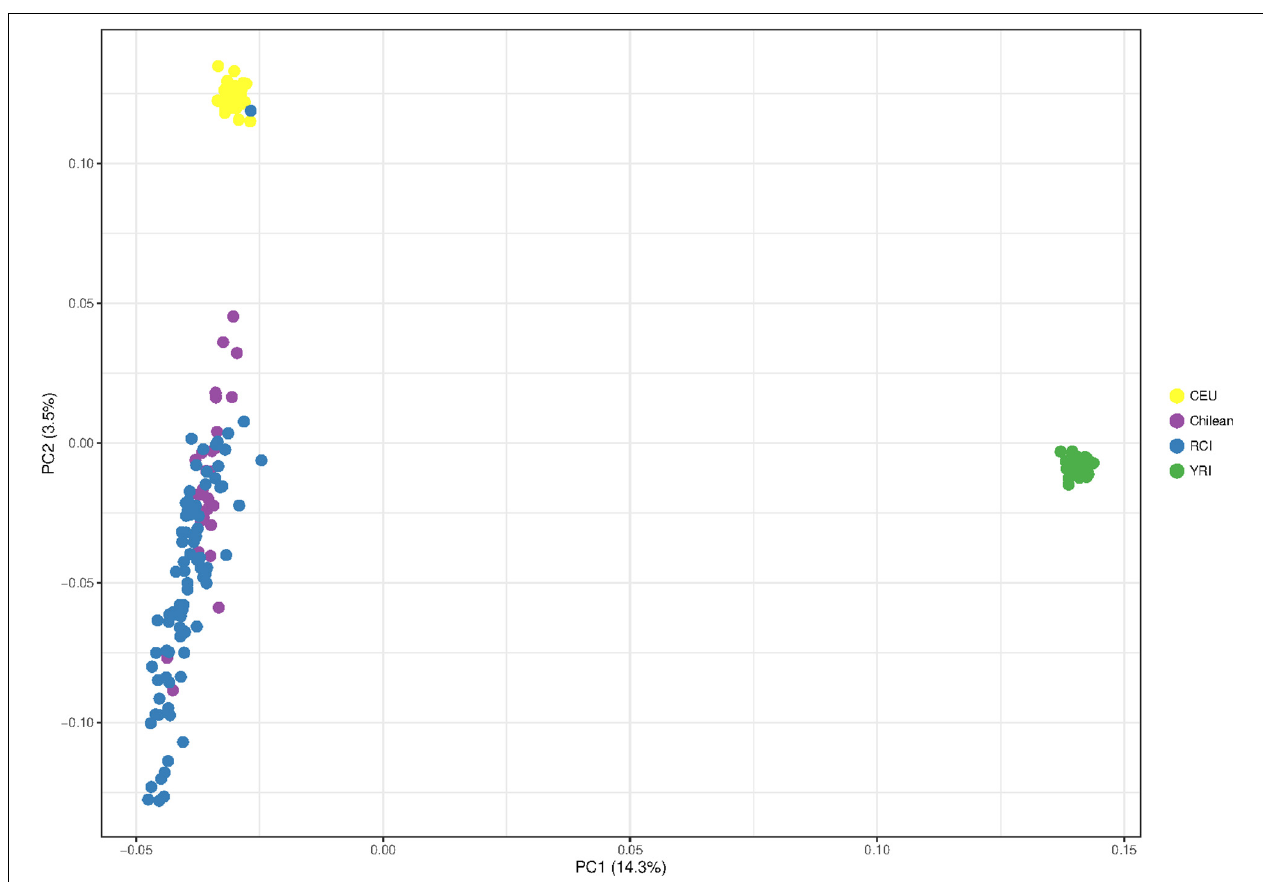
FIGURE 4 | Principal component analysis showing the population structure of Robinson Crusoe Island (RCI) ( N = 86) (blue) ancestry compared to Chilean controls (from Santiago) ( N = 30) (purple), European (CEU) ( N = 40) (yellow) and Yoruba African (YRI) ( N = 40) (green) 1000 Genomes populations.